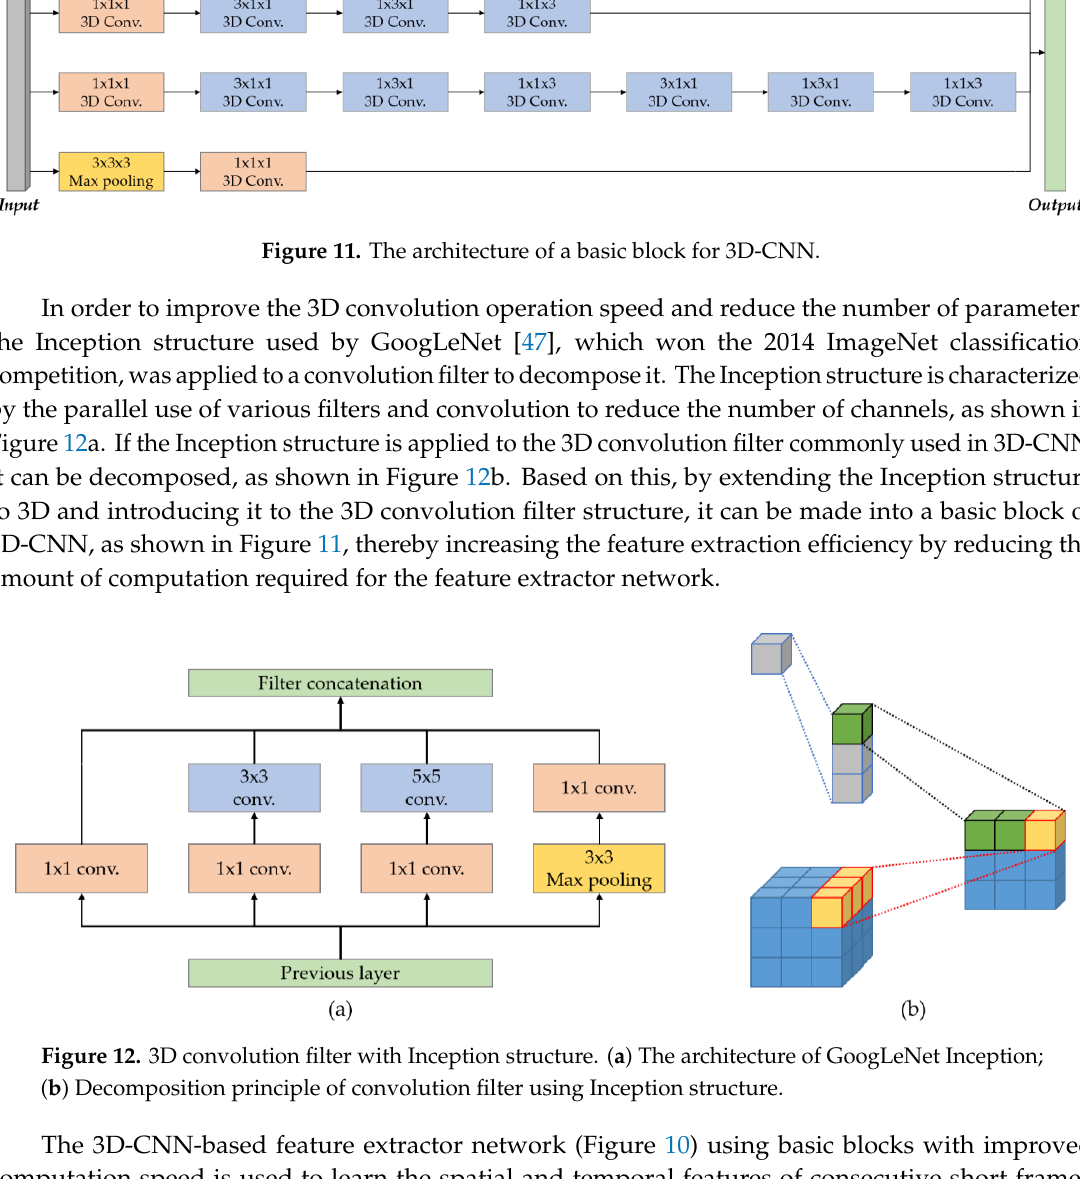
Figure 10. Architecture of a feature extractor based on 3D-CNN.